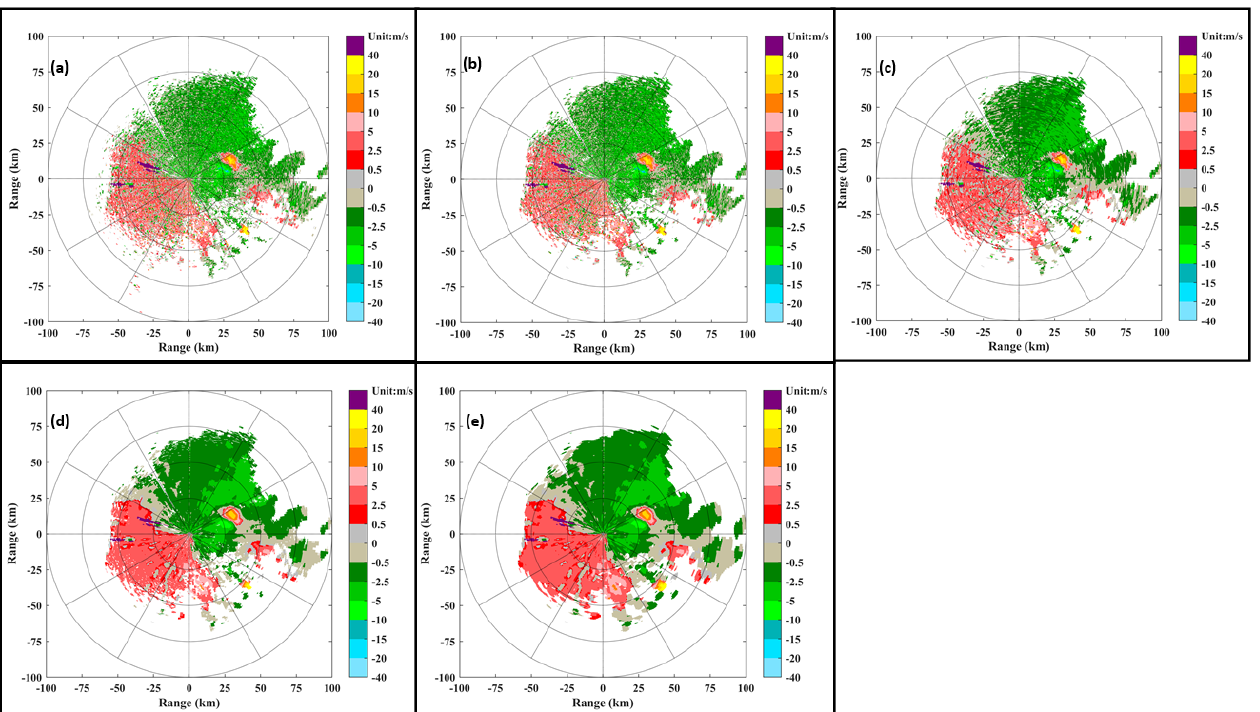
Figure 11 Figure 11. Quality control results of 0.5 ◦ radial velocity. ( a ) Original data, ( b ) removed isolated points, ( c ) median filter result, ( d ) smooth filter result, and ( e ) interpolation